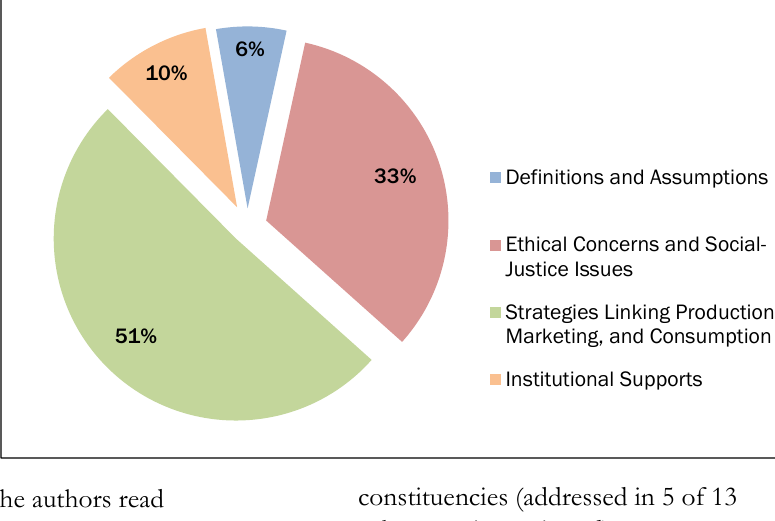
6% 51%10% 33% Definitions and Assumptions Ethical Concerns and Social- Justice Issues Strategies Linking Production, Marketing, and Consumption Institutional Supports